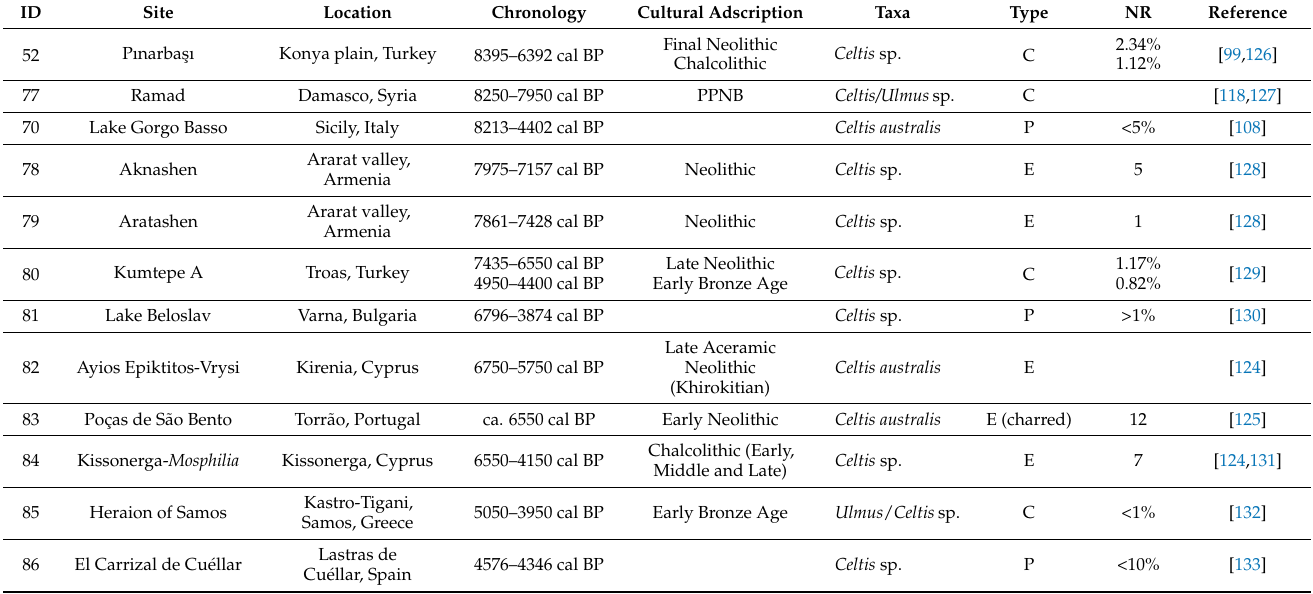
Table 5. Middle Holocene sites where Celtis remains were reported (types of remains: wood charcoal (C), endocarp (E), pollen (P)).